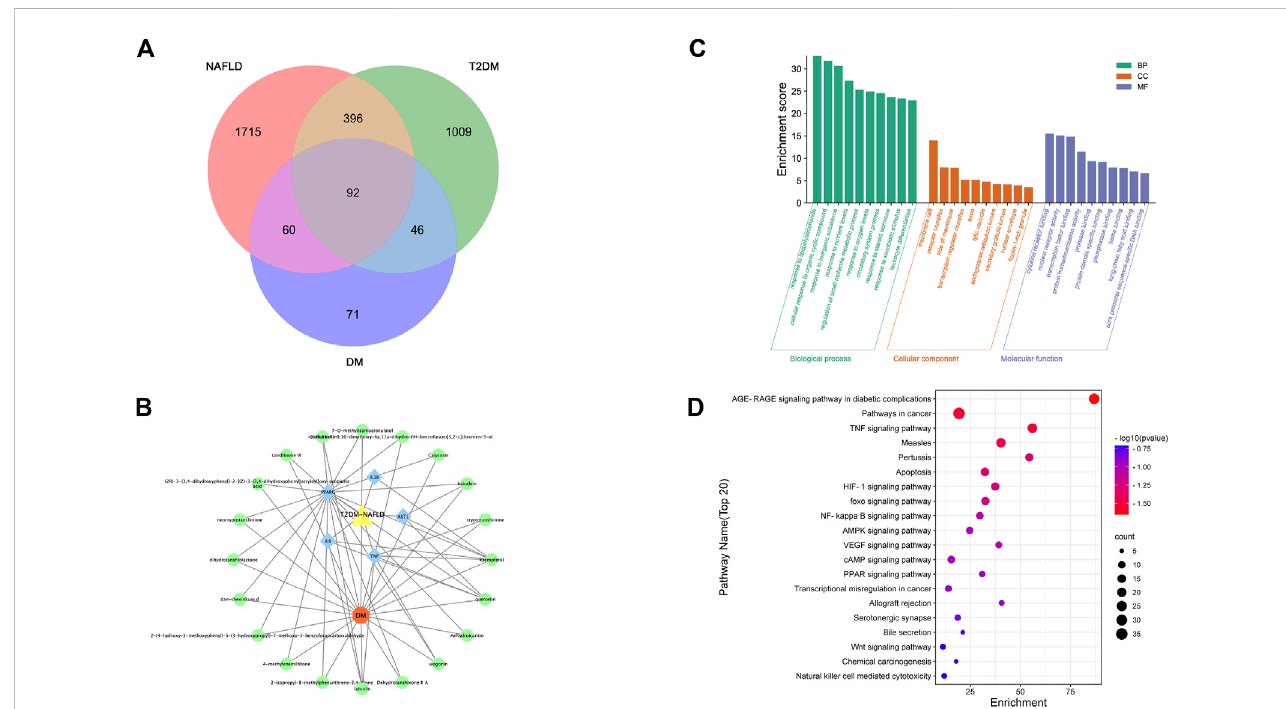
FIGURE 3 (A) Venn of the gene targets of DM, T2DM and NAFLD; (B) Network of “ drug-gene-disease ” . The Orange hexagon represents DM, and the green circles represent components of the DM. The blue square highlighted the gene targets with high degrees. The yellow triangle represents two diseases of NAFLD and T2DM; (C) Top 20 GO terms relevant to the action of DM against NAFLD and T2DM. (D) Top 20 KEGG relevant to the action of DM against NAFLD and T2DM. The count of each KEGG pathway is indicated by the circle size, and the -log10 p -value was indicated by the